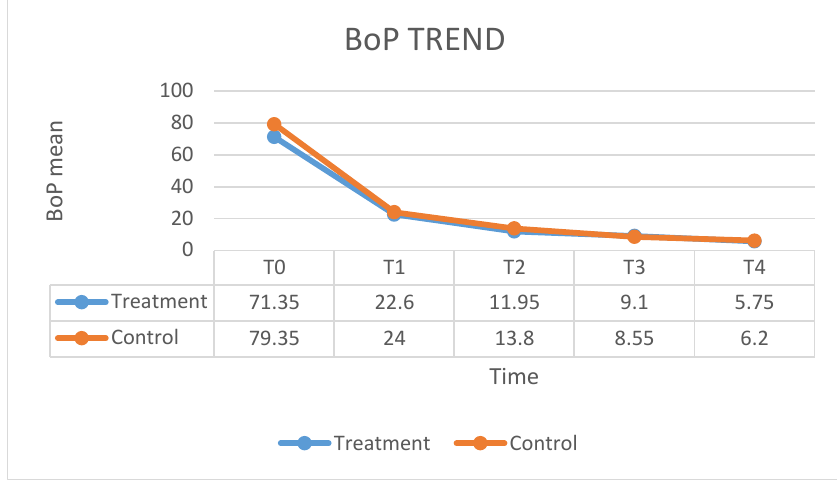
Figure 3. The fluctuation in the BOP means over time.